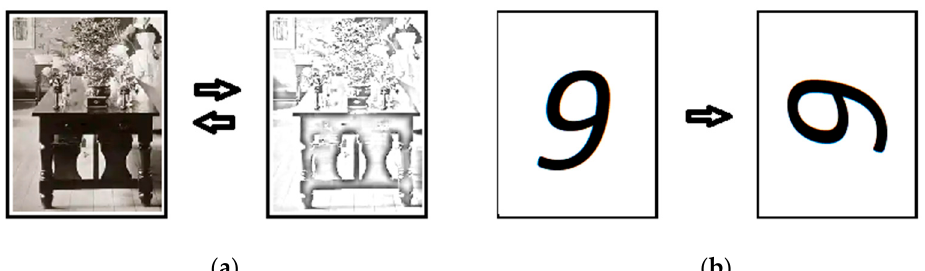
Figure 3. ( a ) The first panel shows a photograph of a visual scene that contains a table along with other objects. The second panel in ( a ) is the same scene but transformed so that it appears as a pen- cil sketch drawing; ( b ) The first panel is a visual drawing of the digit nine (9), while the next panel is the same digit but transformed by rotation of the image.